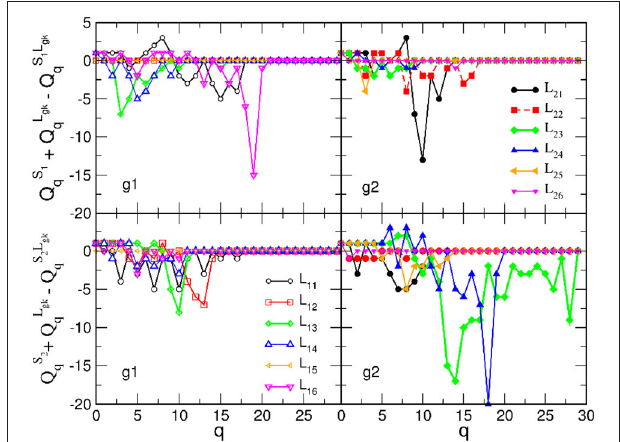
Frontiers in Physics |